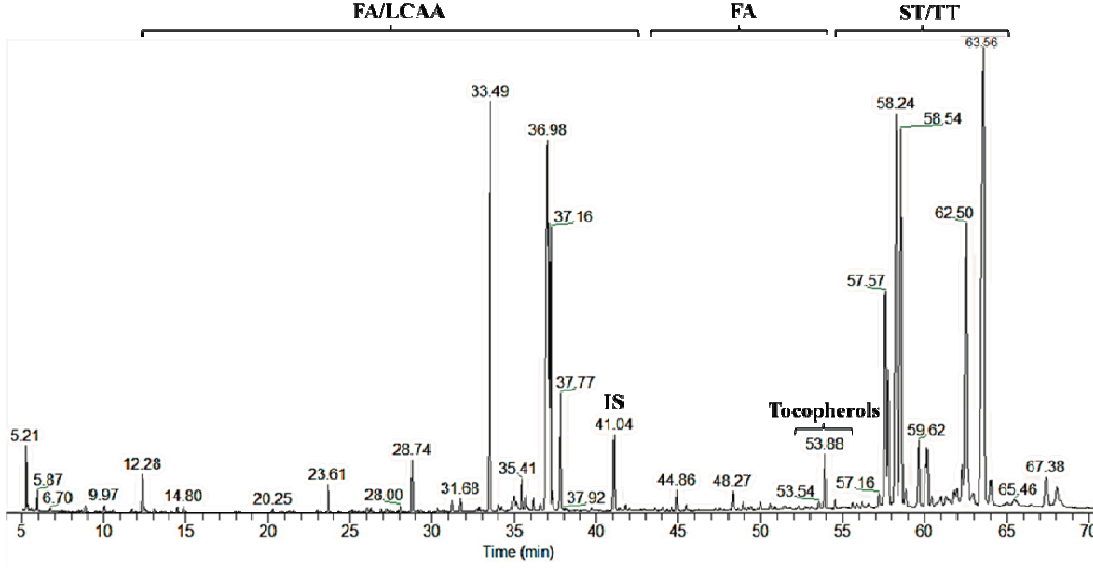
Figure 1. GC–MS chromatogram of the trimethylsilyl (TMS)-derivatized dichloromethane extracts of A. unedo berries after alkaline hydrolysis. Abbreviations: FA, fatty